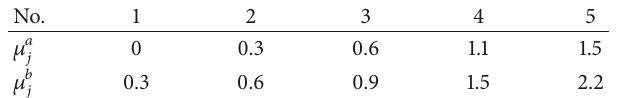
Table 3: Interval bounds for control valve.